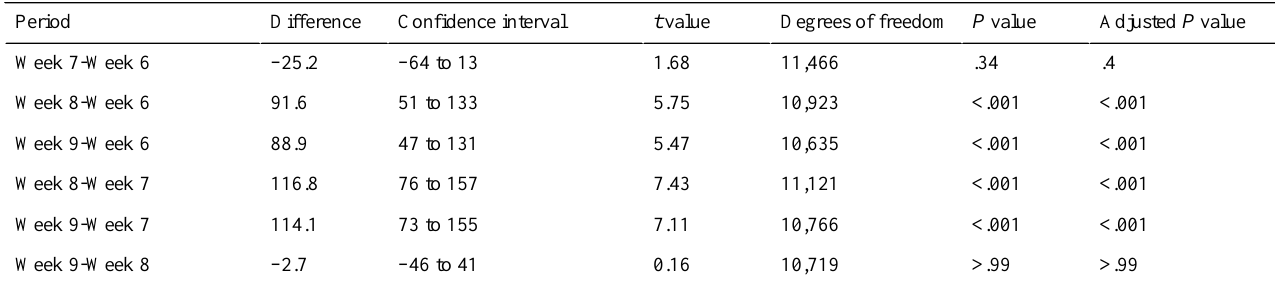
Table 5. Comparisons between weeks in the Pre–COVID-19 period (2020) for common callers.